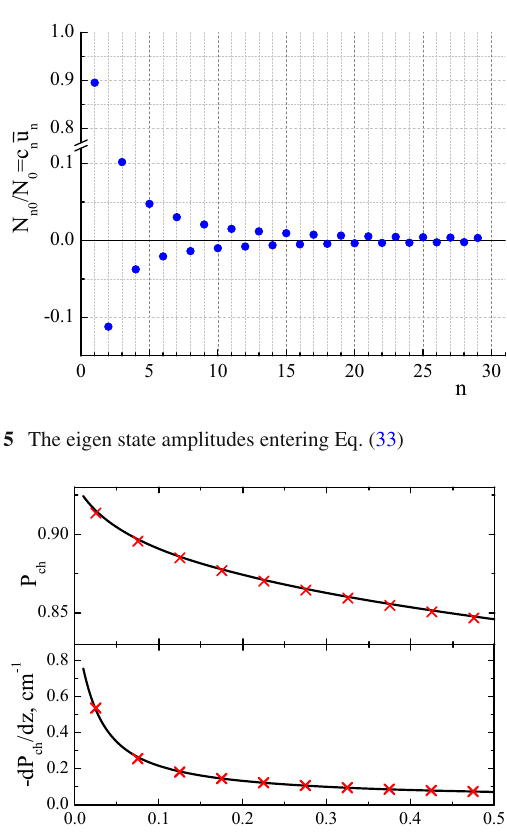
Fig. 4 The eigen values of Eq. (30) ( top ) and corresponding decay lengths ( bottom )